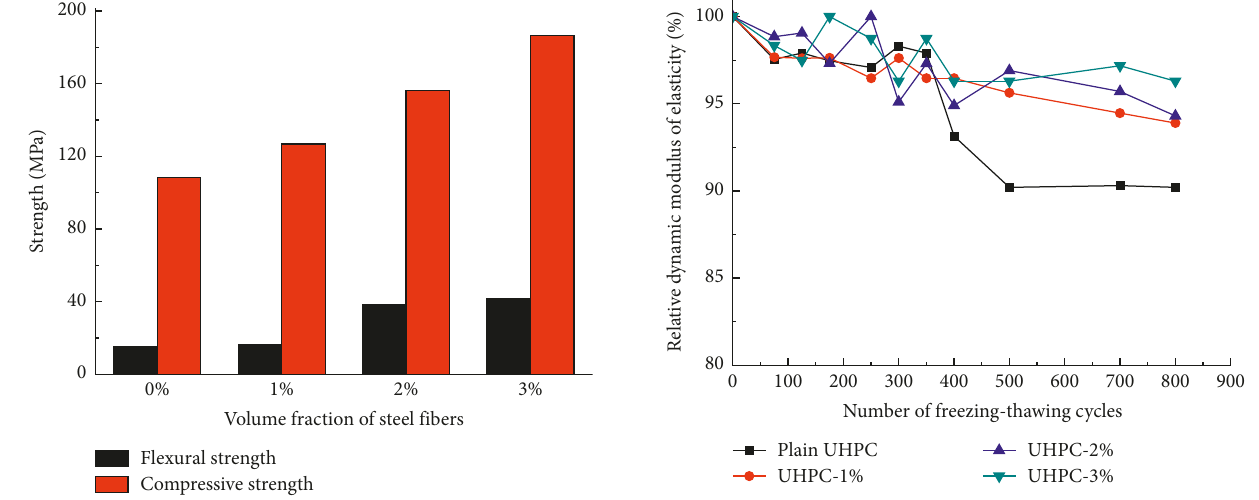
Figure 1: Compressive strength and flexural strength of UHPC specimens.